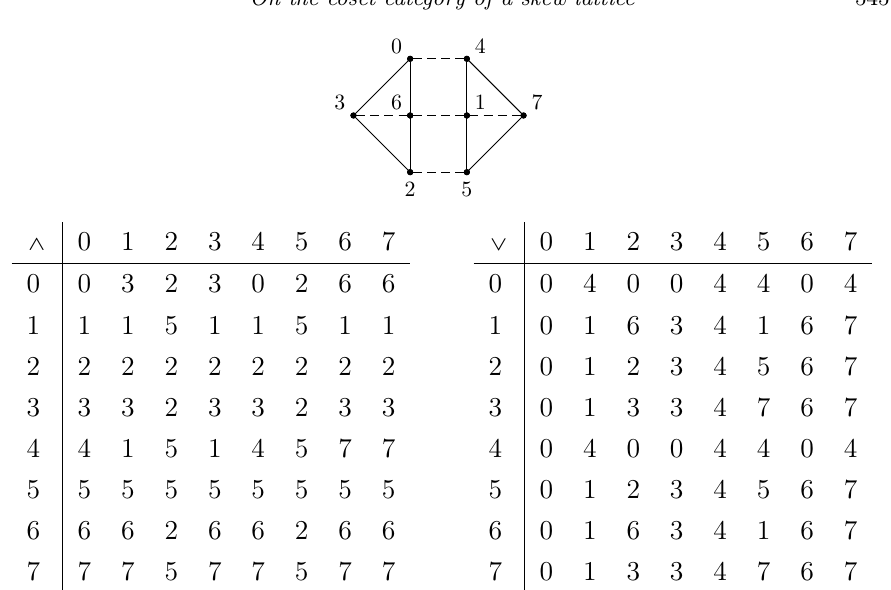
Fig. 2. The admissible Hasse diagram of a left-handed non categorical skew lattice. where this skew lattice is named X